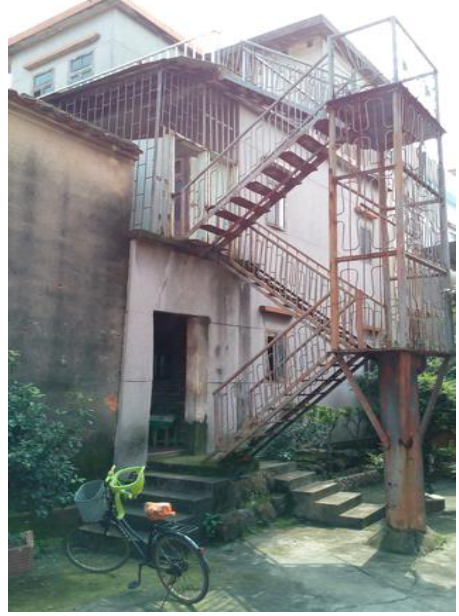
Figure 9. Additional steel ladder (source: the authors).